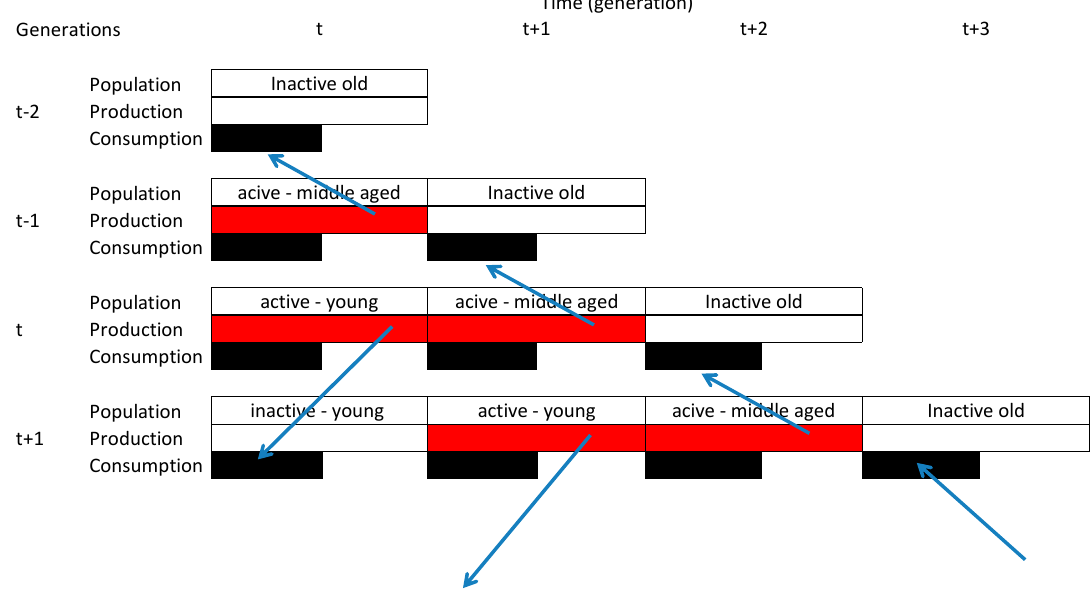
Figure A1. The modified Samuelson model for stationary case when population is stable.